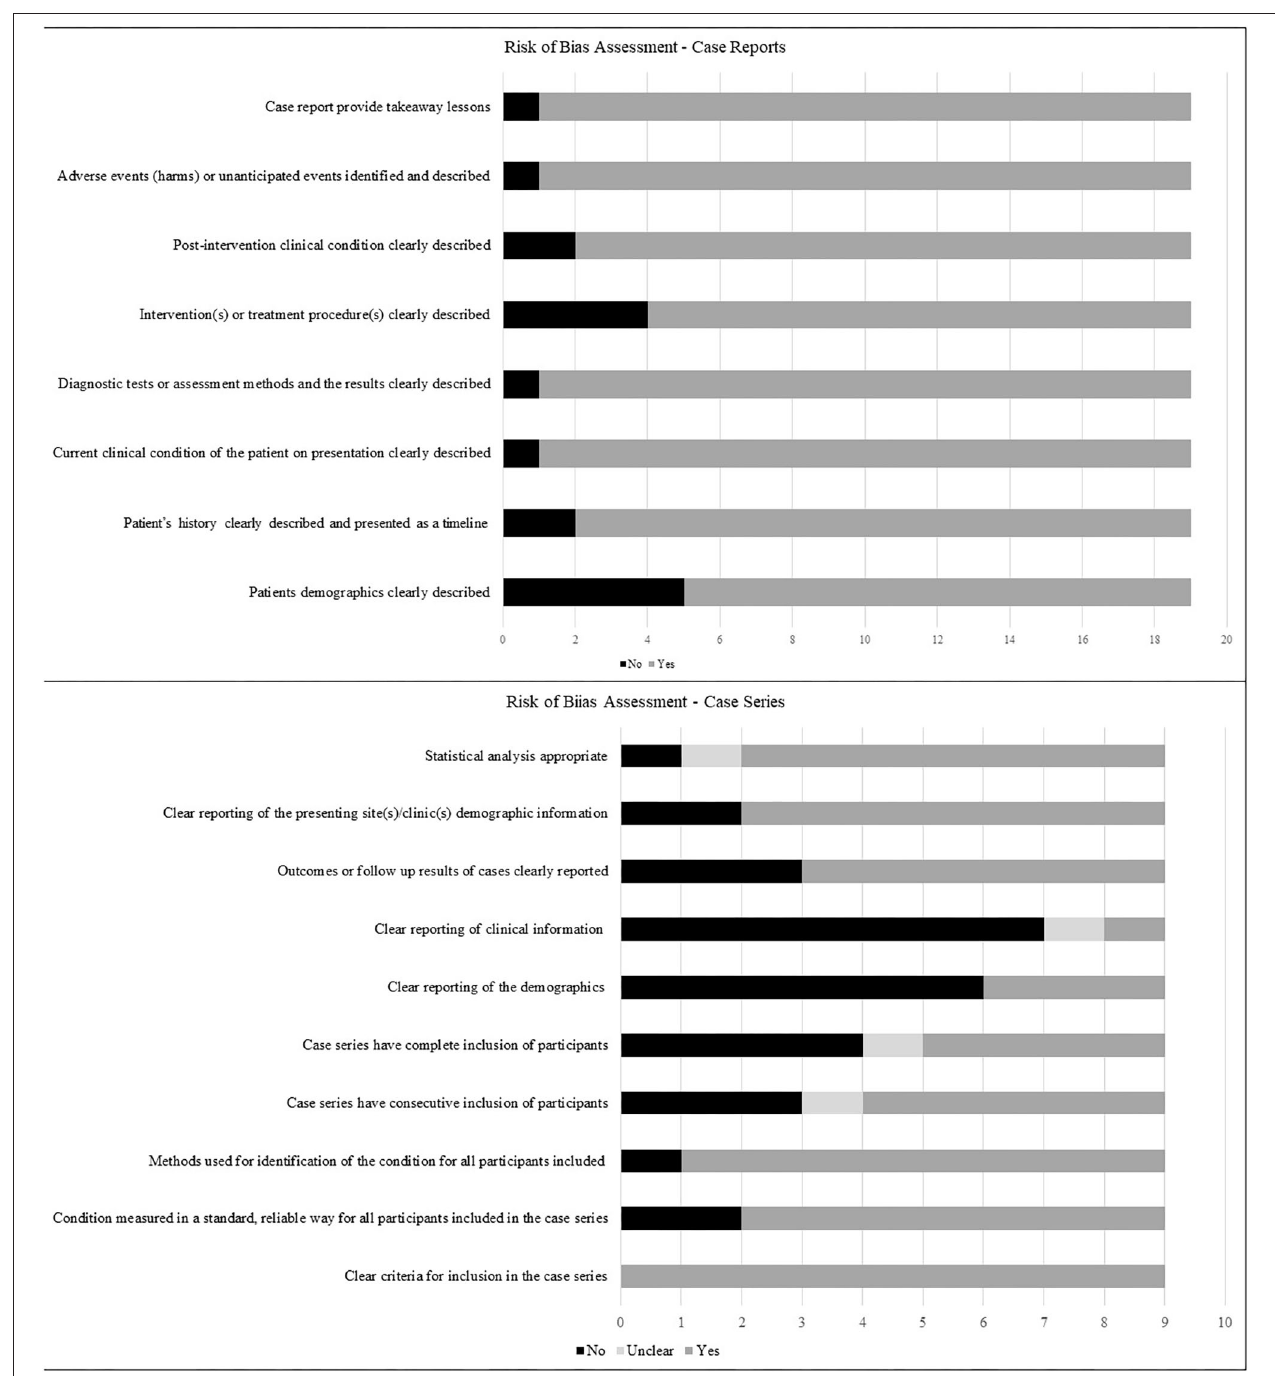
FIGURE 2 | Risk of bias of included studies describing the proportions of studies fulfilling the criteria for case reports and case series as outlined in Joanna Briggs’ critical appraisal tools.